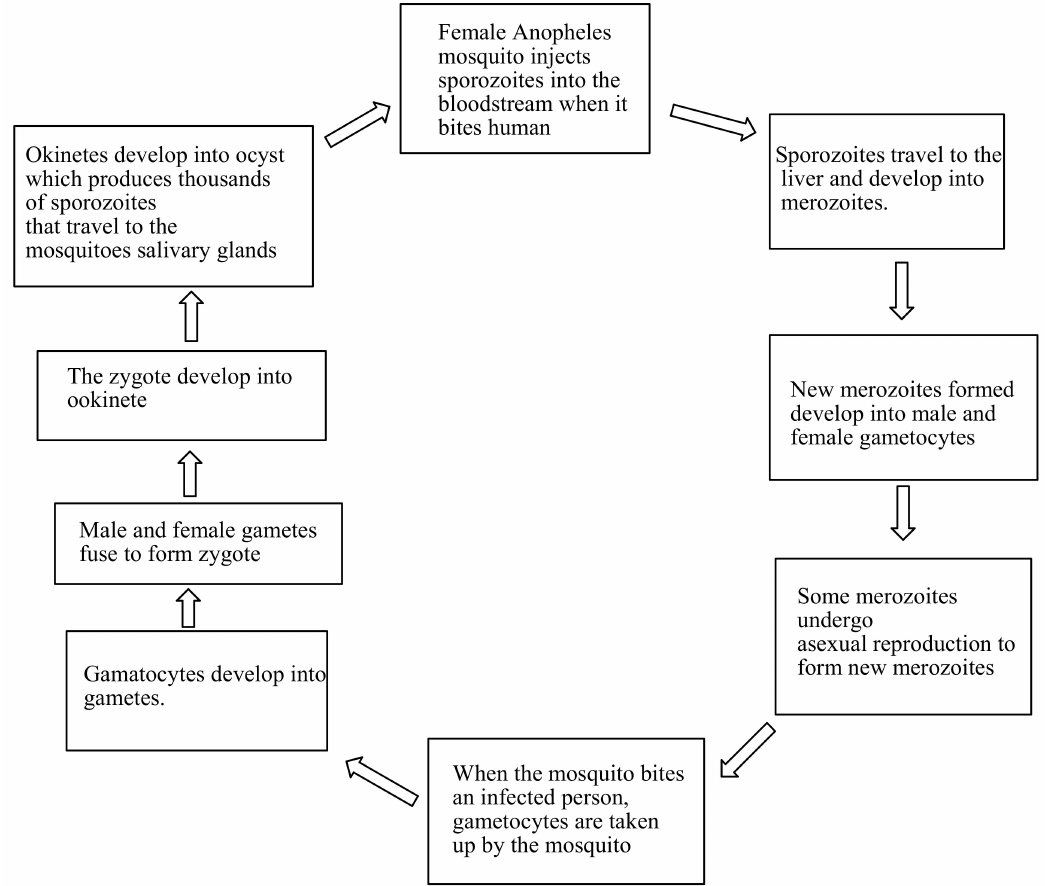
Figure 1. The life cycle of malaria